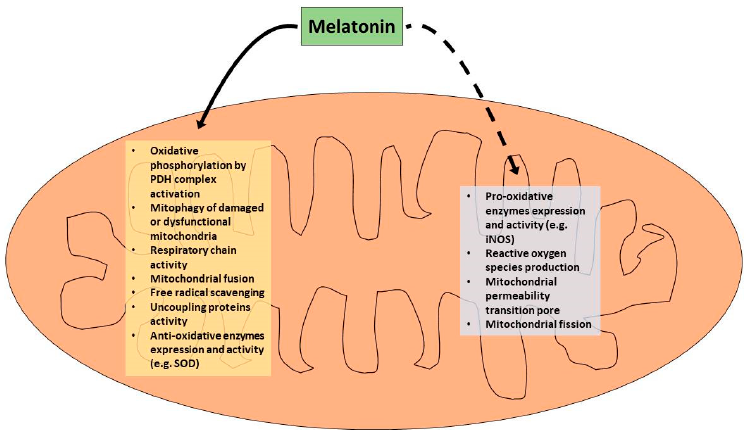
Figure 2. Roles of melatonin in the mitochondrion. The continuous line indicates “stimulation”, and the dashed line indicates “inhibition”.